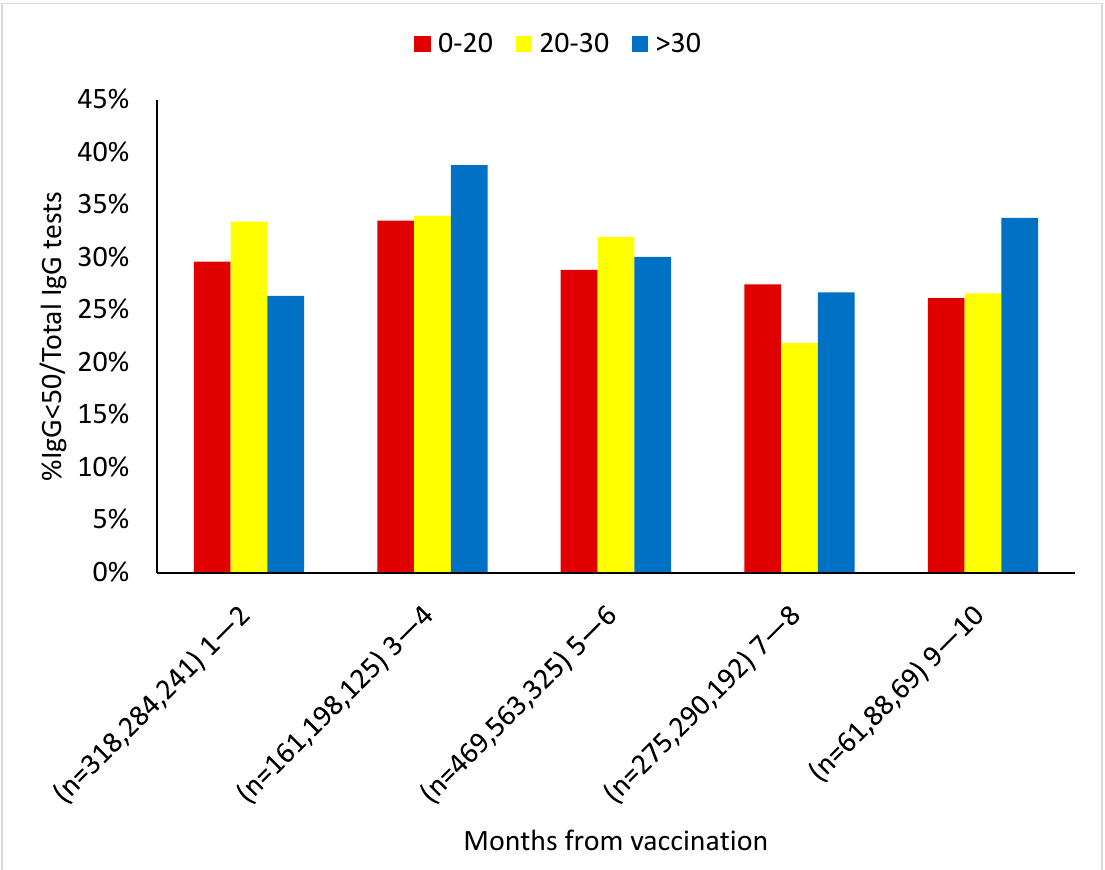
Figure 5. % Antibody titer < 50 AU/mL from the vaccinated group stratified by baseline 25(OH)D levels at each time point since the 2nd vaccination. The Pearson Chi-square test was applied here.